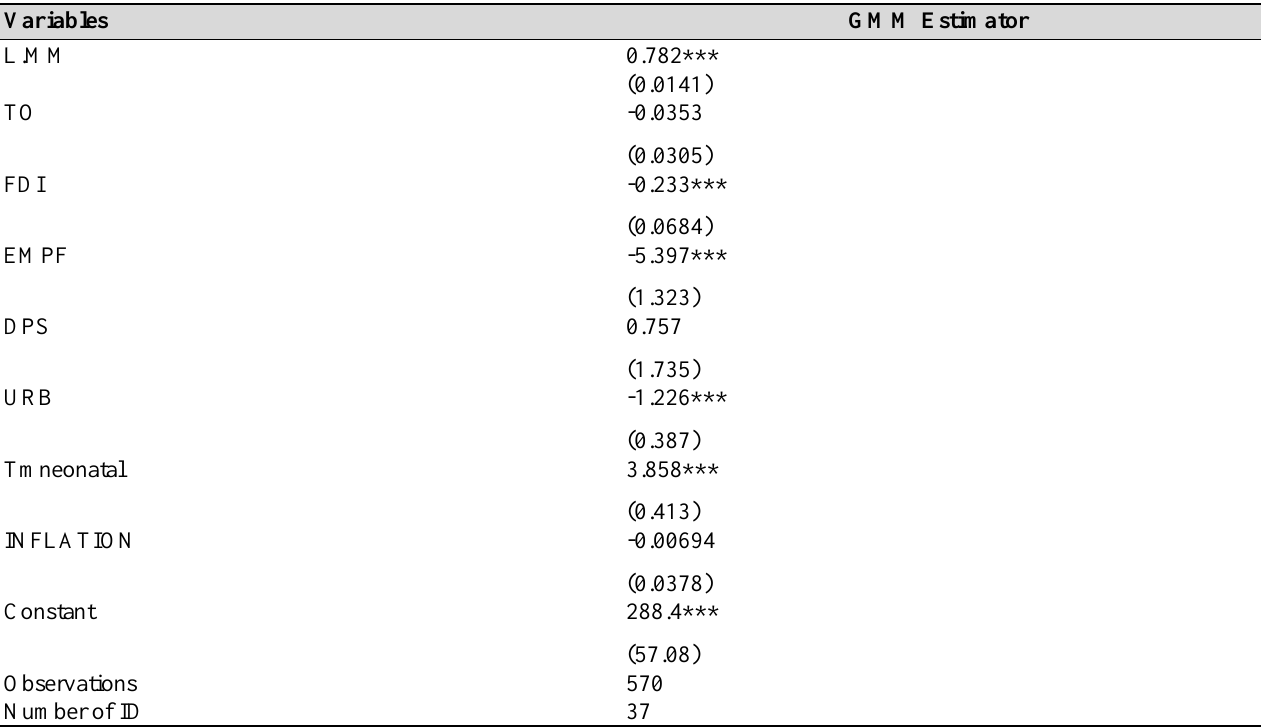
Estimates Results of the Effect of Globalization and Women's Employability on Maternal Health in Sub-Saharan Afric